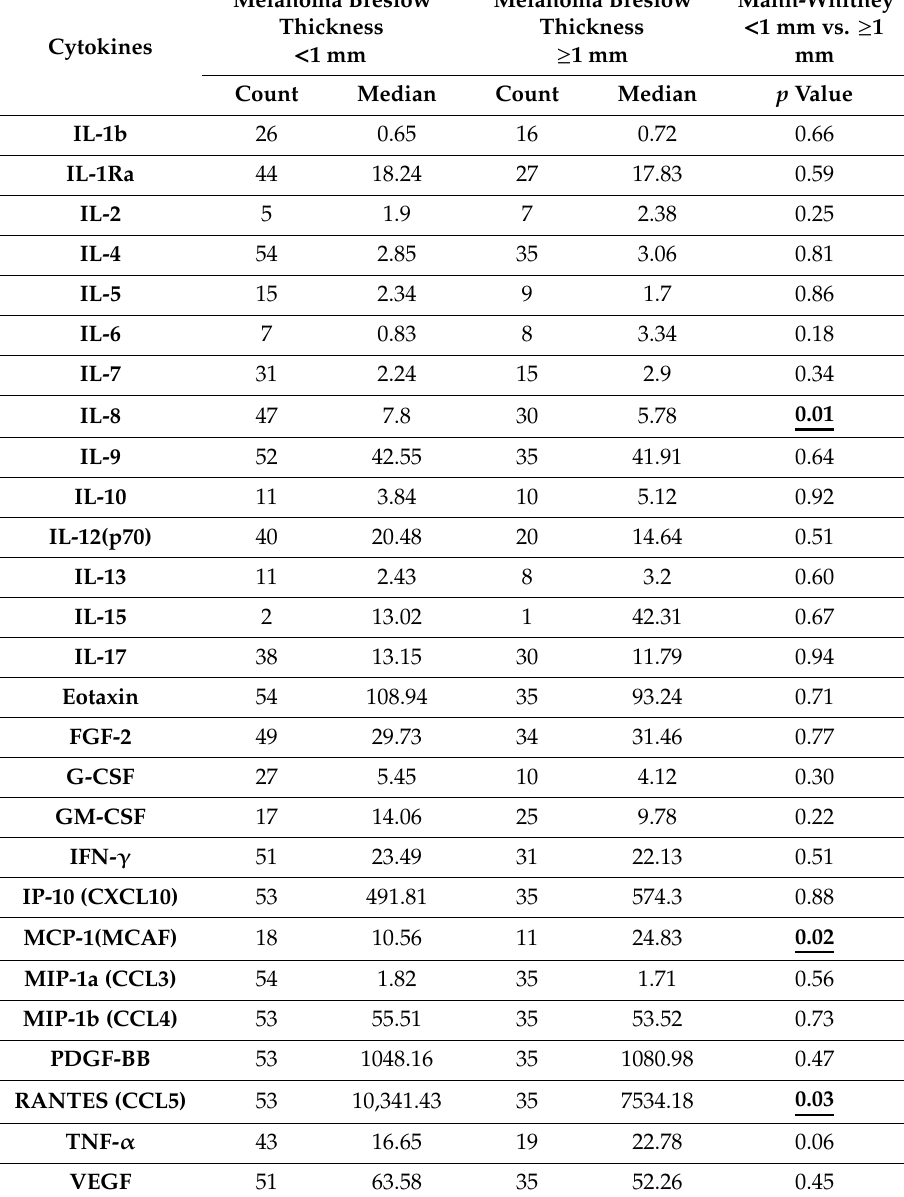
Table S3 reports the correlations with Breslow thickness in male melanoma and in female melanoma patients and shows that the cytokines with significant correlations are di ff erent in males vs. females. Table 3. Serum expression as a function of Breslow thickness. Count indicates the number of patients analyzed. The median expression values of the 27 molecules with a Breslow thickness < 1 mm or > 1 mm are reported. The significance of the di ff erence according to the Mann–Whitney analyses is also reported: for p -values > 0.05, the null hypothesis that the two distributions of cytokine expressions have the same median should be rejected (significant values are reported in bold and are underlined). In simpler words, when the p -value is < 0.05, the cytokine expressions in patients with a Breslow thickness < 1 mm and expression in patients with a thickness > 1 mm have significantly di ff erent